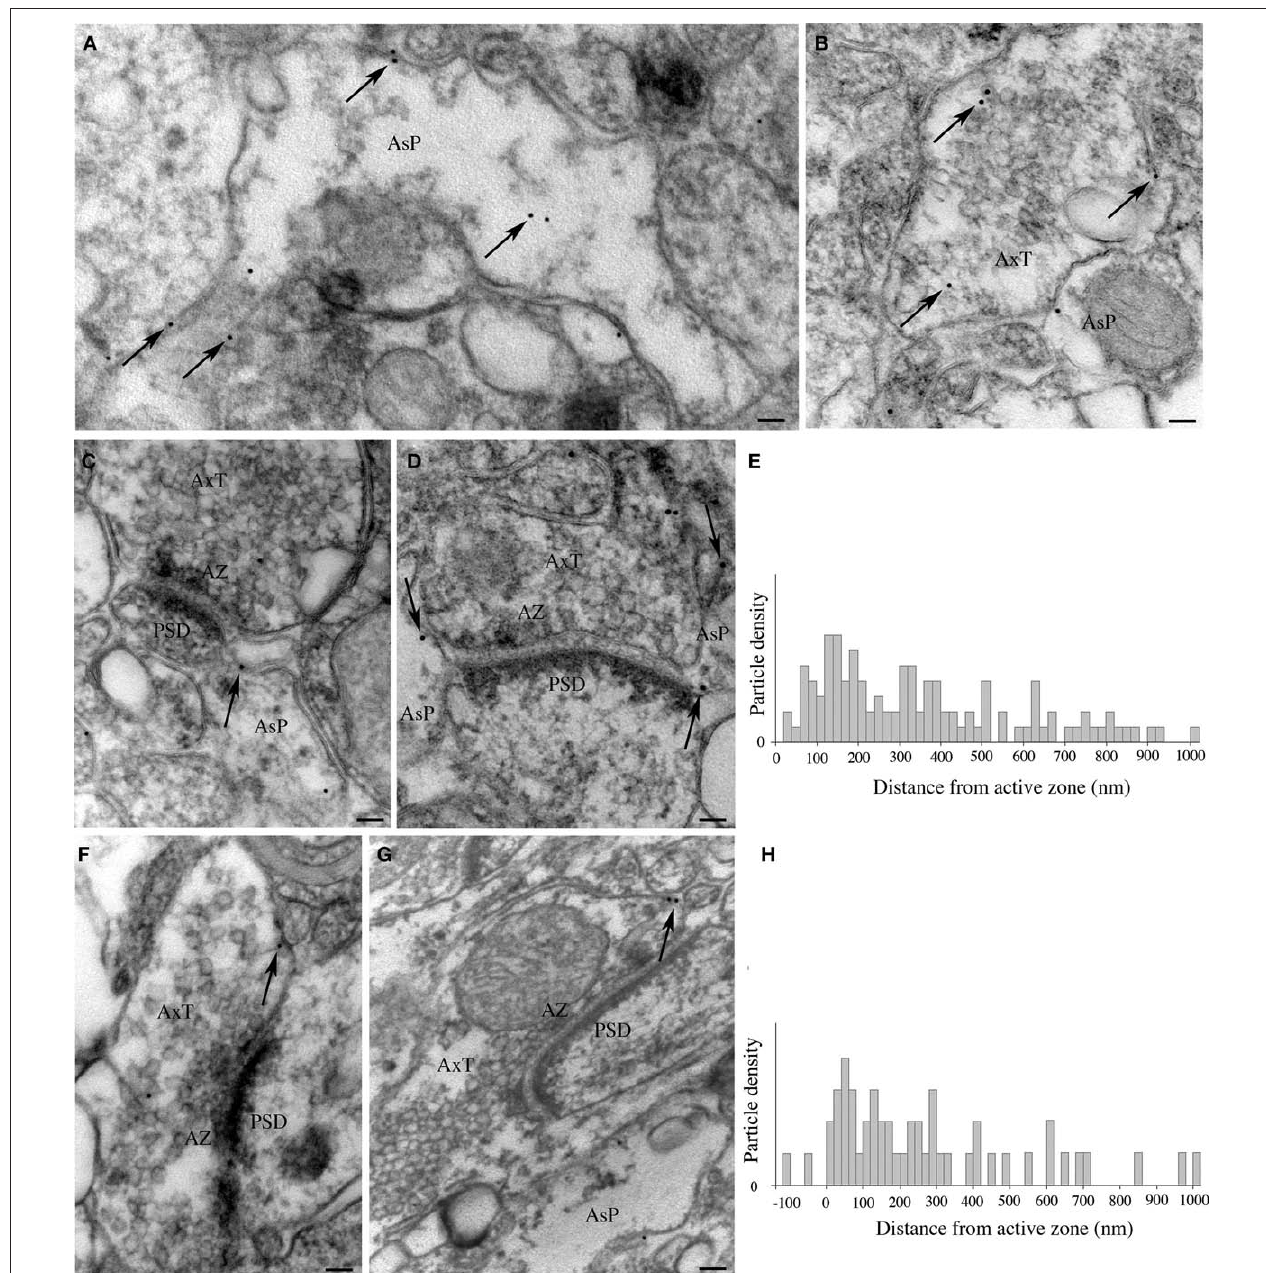
distance of gold particles detected in astrocytic processes (E) and axon terminals (F) from the AZ edge of terminals forming asymmetric synapses. The y -axis indicates the density of particles for each bin (20 nm), obtained by dividing the number of particles counted in each bin by the number of profiles extending that far. Den, dendrite; AsP, astrocytic process; AxT, axon terminal; AZ, active zone; PSD, post-synaptic density. Scale bars: 60 nm for (A,B) ; 100 nm for (C,D,F,G)